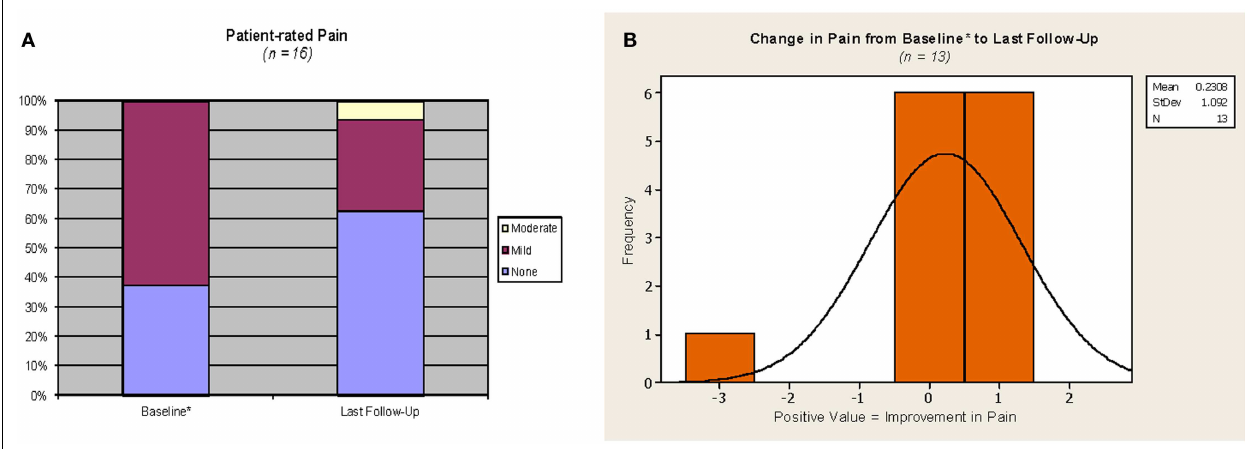
FIGURE 4 | Pain outcomes. *For the three cases on the phase 2 protocol, which did not require a baseline assessment, values from the 1month assessment were used as proxy for baseline. Phase III protocol questionnaire responses were converted as follows: no pain = none, mild tenderness or